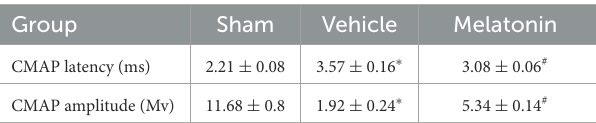
TABLE 1 The results of electrophysiological evaluation in all three groups. Group Sham Vehicle